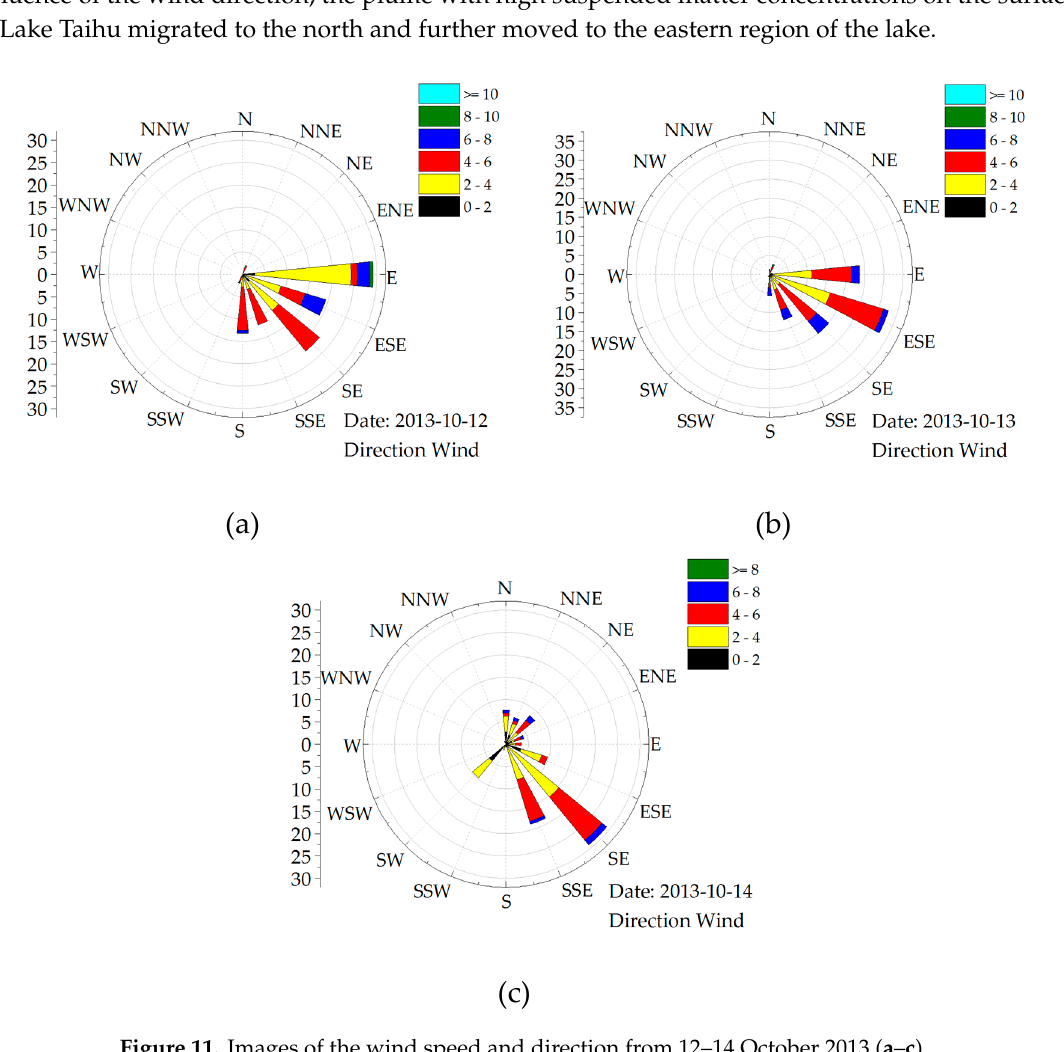
Figure 10. The daily mean sediment concentration provided by the Gangkou Station.